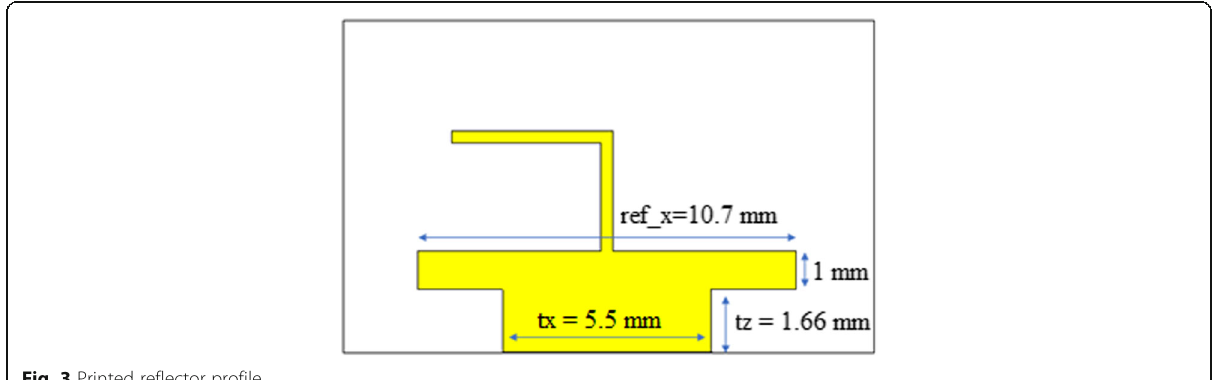
Fig. 3 Printed reflector profile